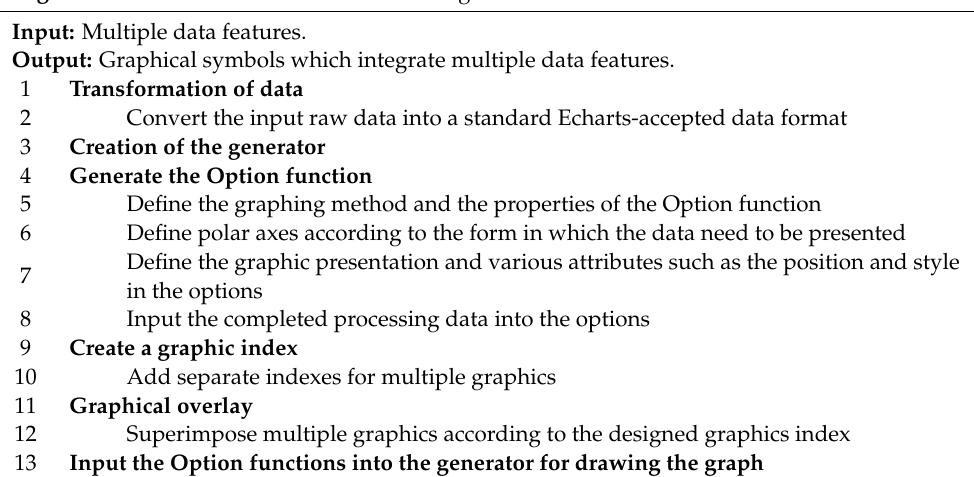
Algorithm 1 Visualization-driven data mining